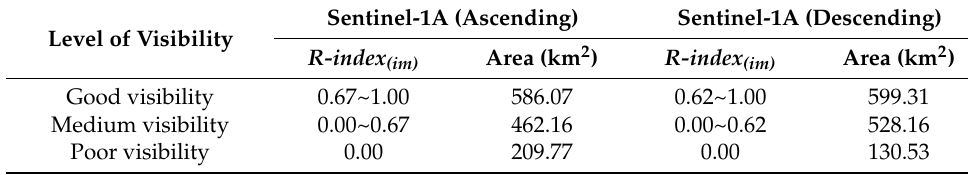
Figure 7. SAR visibility analysis results of the SAR images in the study area: ( a ) Ascending Sentinel- 1A images; ( b ) Descending Sentinel-1A images. Table 2. Statistical information of the areas with different levels of SAR